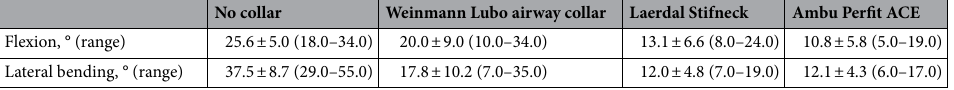
Table 1. Results of the remaining motion examination of the three cervical collars and the control